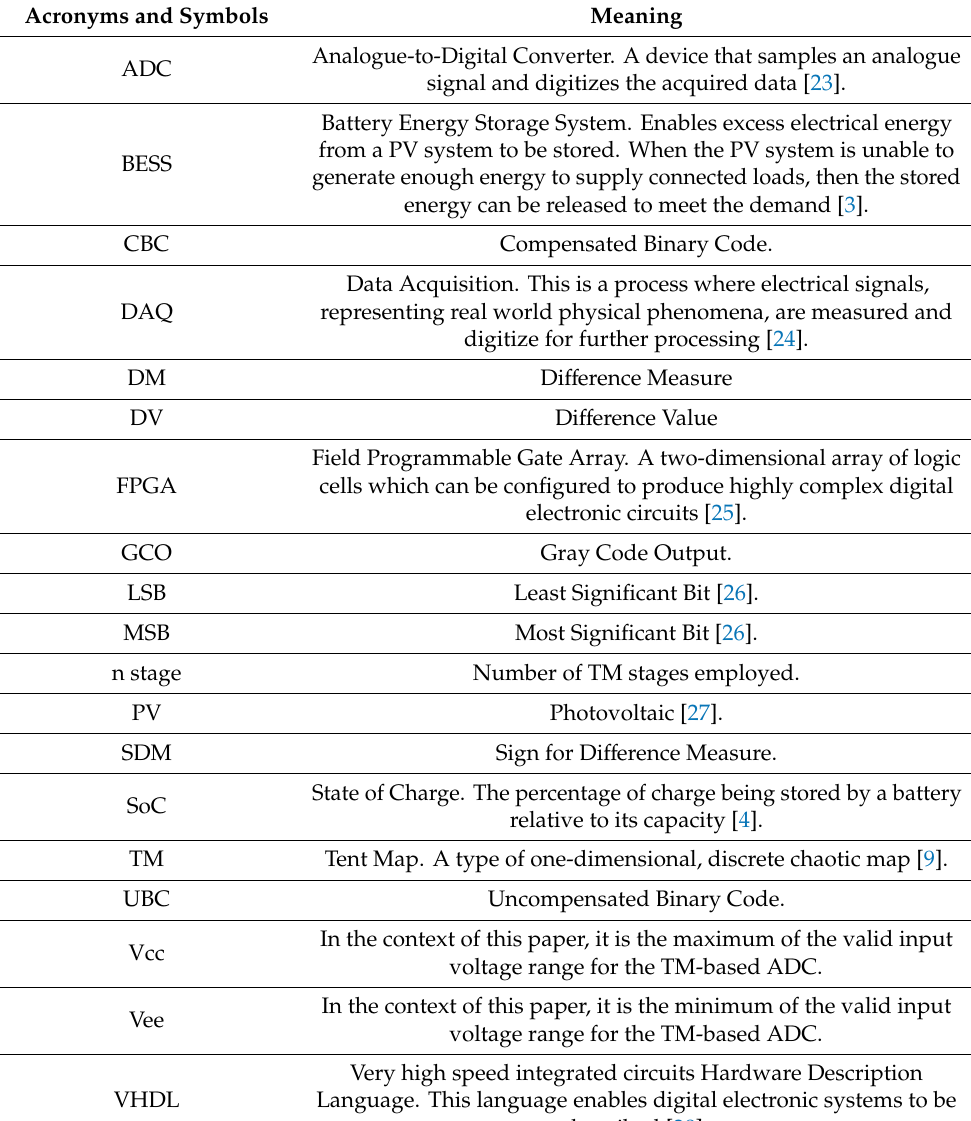
Table A1. List of Acronyms and